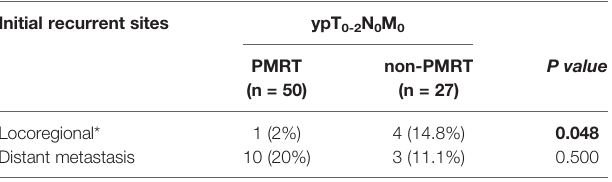
TABLE 3 | Recurrence patterns in the ypT 0-2 N 0 PMRT and non-PMRT subgroups. Initial recurrent sites